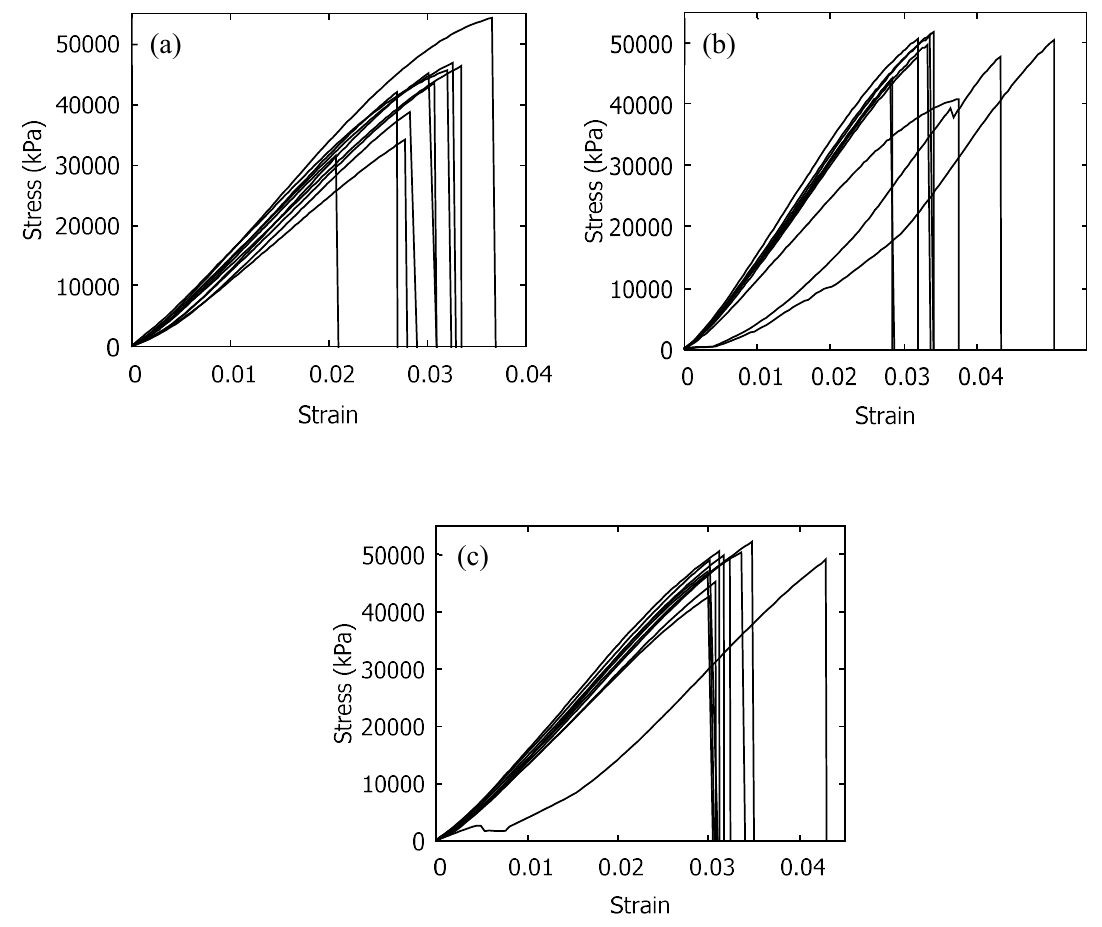
Figure 11. Stress–strain curves for 10 samples at different strain rates for 212 µm filler-reinforced composites: ( a ) 0.00028 s −1 , ( b ) 0.00085 s −1 , and ( c ) 0.0017 s −1 .